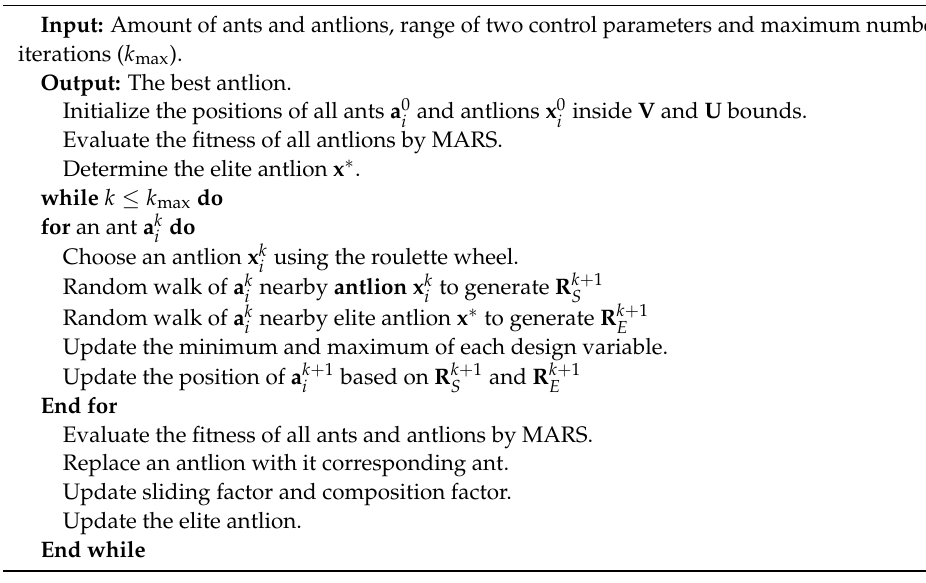
Algorithm 1: Pseudo-code of the R ALO